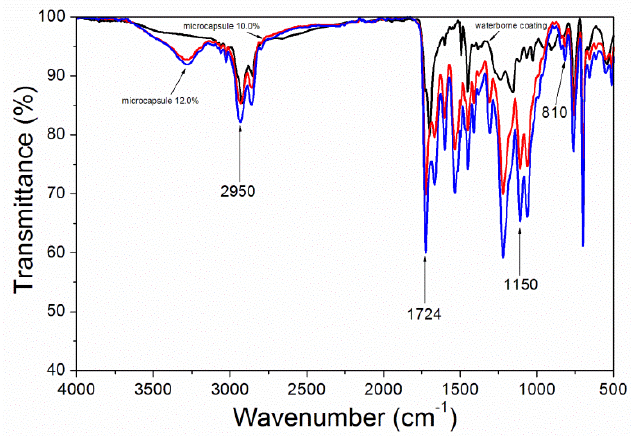
Figure 7. Influences of microcapsules on infrared spectrum of coatings.